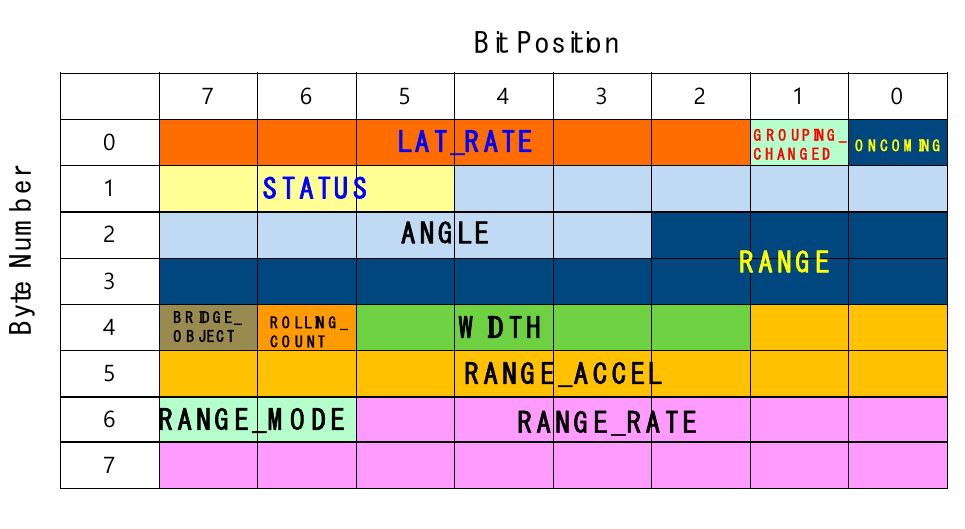
Figure 4. Bit map for radar data.